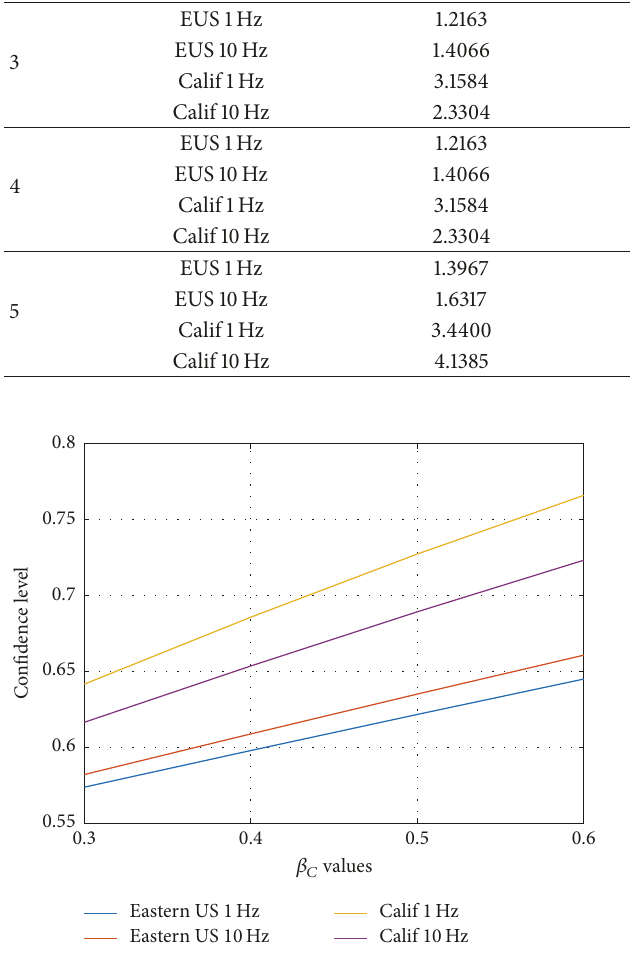
Figure 4: Confidence levels of achieved performance probabilities for SDCs 3 and 4 based on the first and second criteria of ASCE/SEI 43-05 for representative hazard curves.